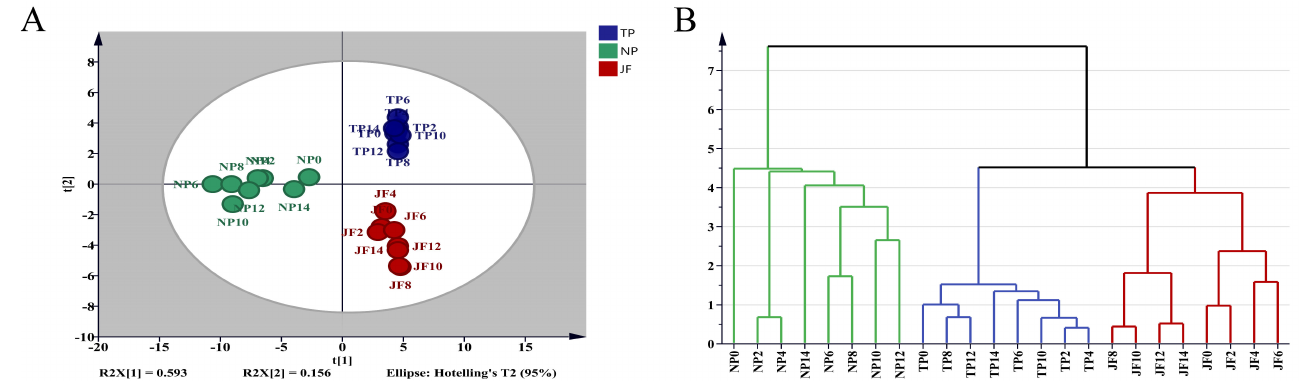
Figure 3. Comparison and analysis of volatile components in jasmine during the different scenting processes. ( A ) PCA score chart. ( B ) HCA